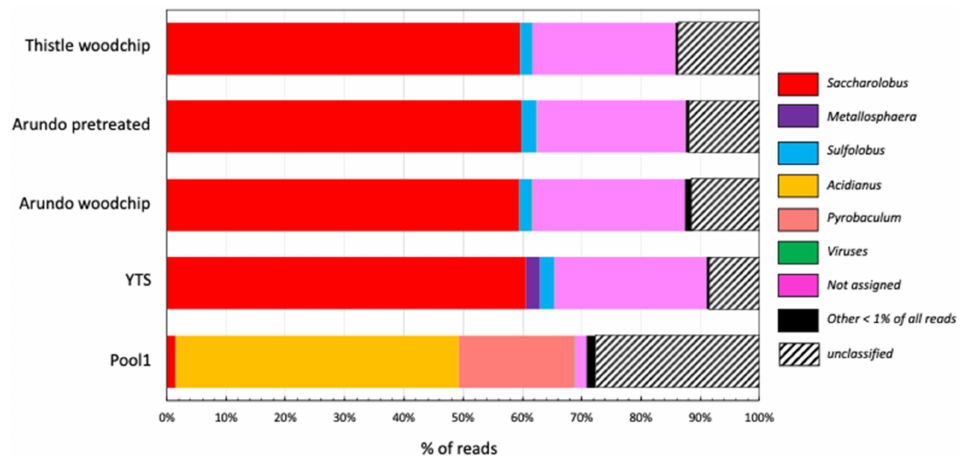
Figure 1. Taxonomic annotation at the genus